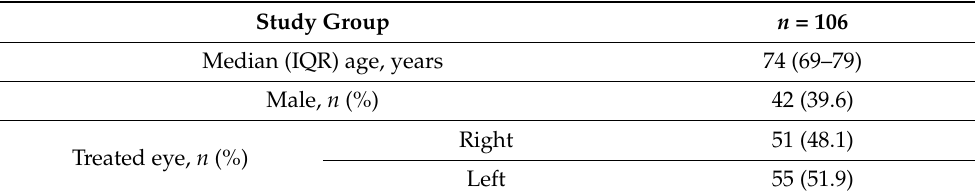
Table 1. Characteristics of the study